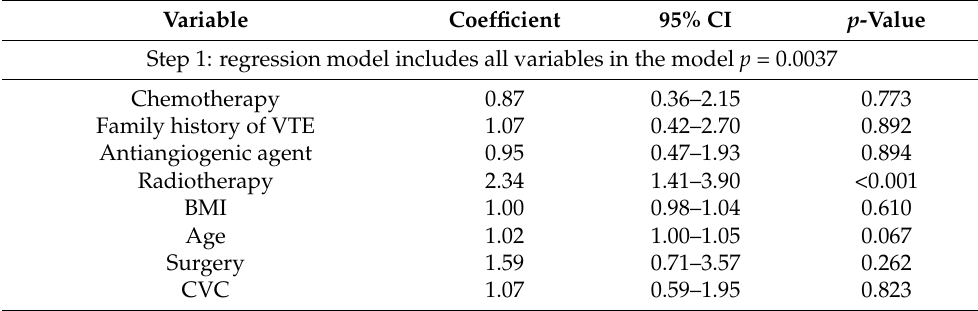
Table 2. Competing-risks regression model examining variables influencing VTE at 6 months *.